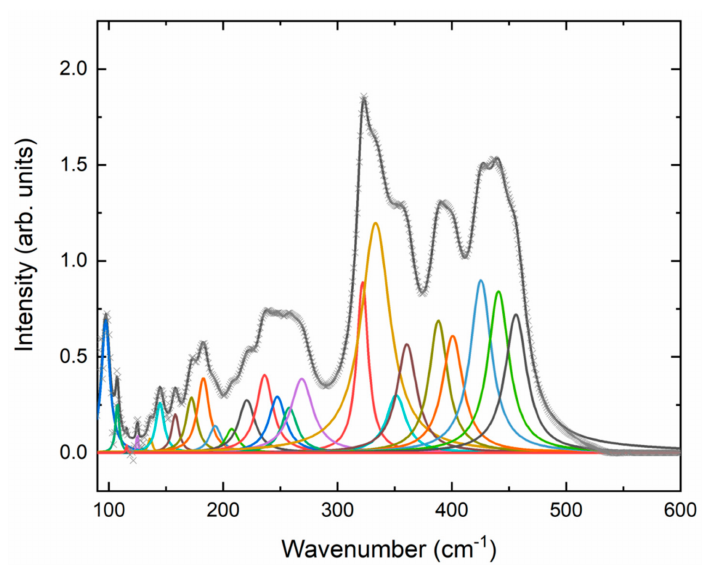
Figure 2. Far-IR spectrum of Zn(IO 3 ) 2 measured at 0.9 GPa and room temperature. The Gaussians used for the multiple peak fit are also shown in different colors. Each of them corresponds to the phonons summarized in Table 1. Table 1. A comparison of the phonon frequencies determined by IR- and Raman-spectroscopy from this work (at 0.9 GPa) and from previous studies (ambient pressure). For the present study, frequencies are given with errors. The horizontal dashed line indicates the cut-off of the IR set-up, below which it was not possible to detect signal due to experimental constraints.